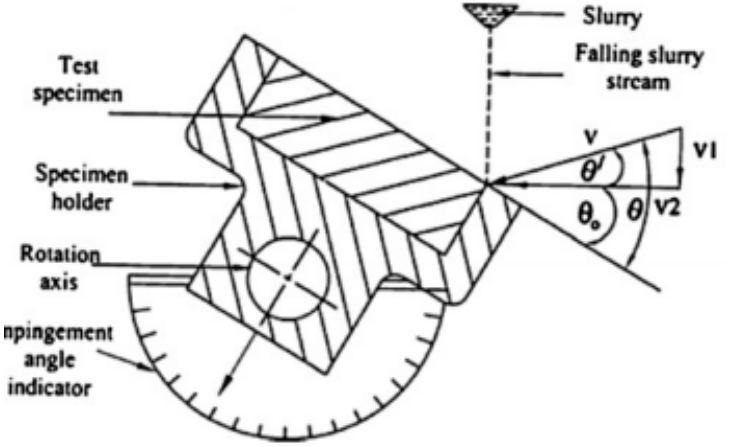
Table 3. Testing conditions for slurry impact of FDM ‐ processed PLA.